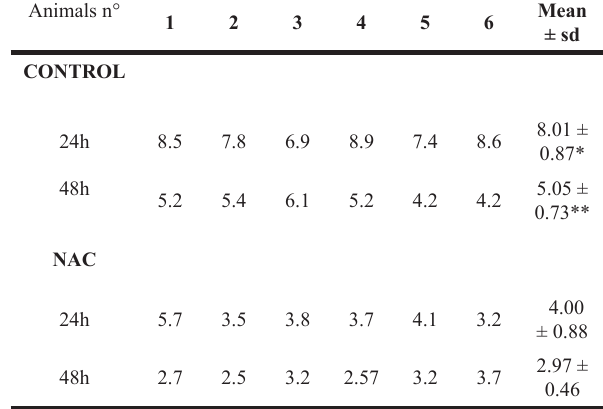
TABLE 3 - Distribution of the mean ± standard deviation of the alveoli thickness (mM) in the lung parenchyma for each animal in each group reading of 1000 cells counted in 20